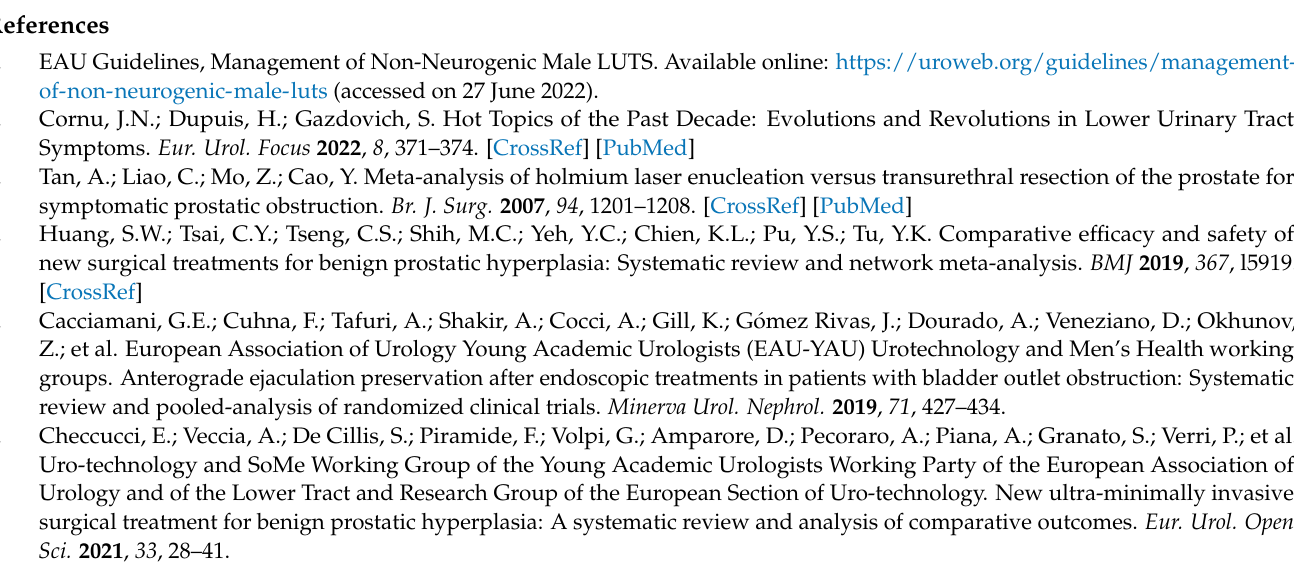
Table S1: PICOTS (Population, Intervention, Comparators, Outcomes, Timing, and Setting) format; Table S2: Level of evidence for the evaluated studies according to GRADE and Oxford systems, and quality of the studies assessed with Newcastle-Ottawa scale; Table S3: Summary of rates and type of complications or sequelae and associated management in patients treated with transperineal laser ablation (TPLA) for benign prostatic enlargement (BPE) in the six included